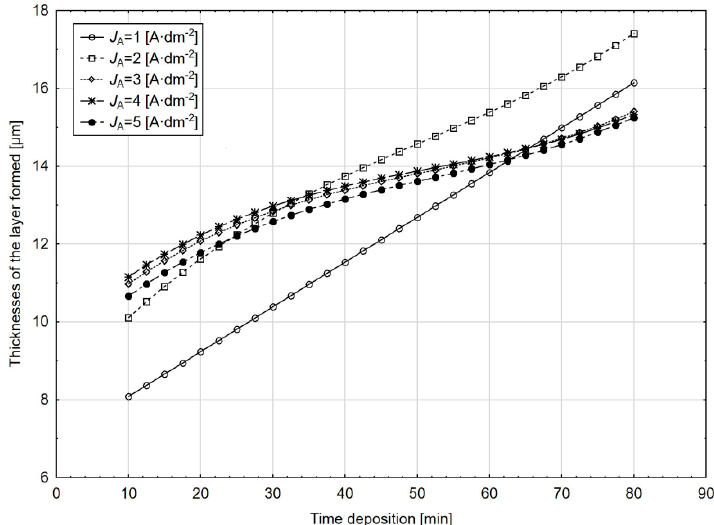
Figure 12. Influence of the anodic oxidation time at the current density of 1–5 A · dm − 2 , for the sulphuric acid amount of in the solution of 200 g ⋅ L − 1 and the electrolyte temperature of 18 °C.